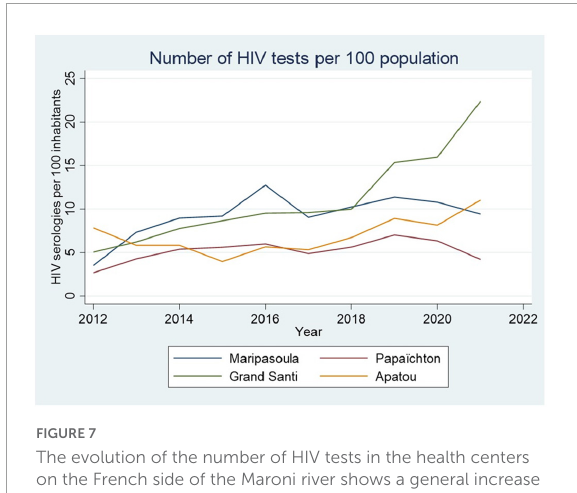
FIGURE8 The blue and red bars show the population numbers (bottom) , patients (middle) , and lost to follow-up patients in French Guiana and Suriname. There is a greater demographic weight of the French side of the Maroni river but an even greater imbalence in HIV patients followed on the French